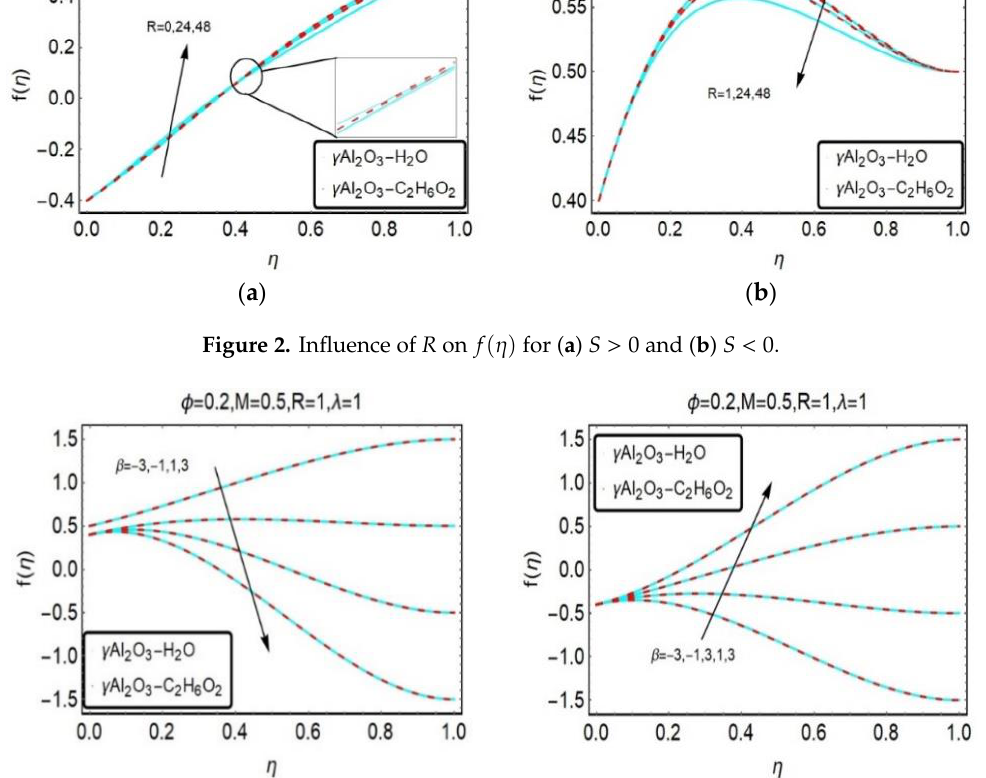
( b ) Figure 4. Influence of 𝑀 2 on 𝑓(𝜂) for ( a ) 𝑆 > 0 and ( b ) 𝑆 < 0 .